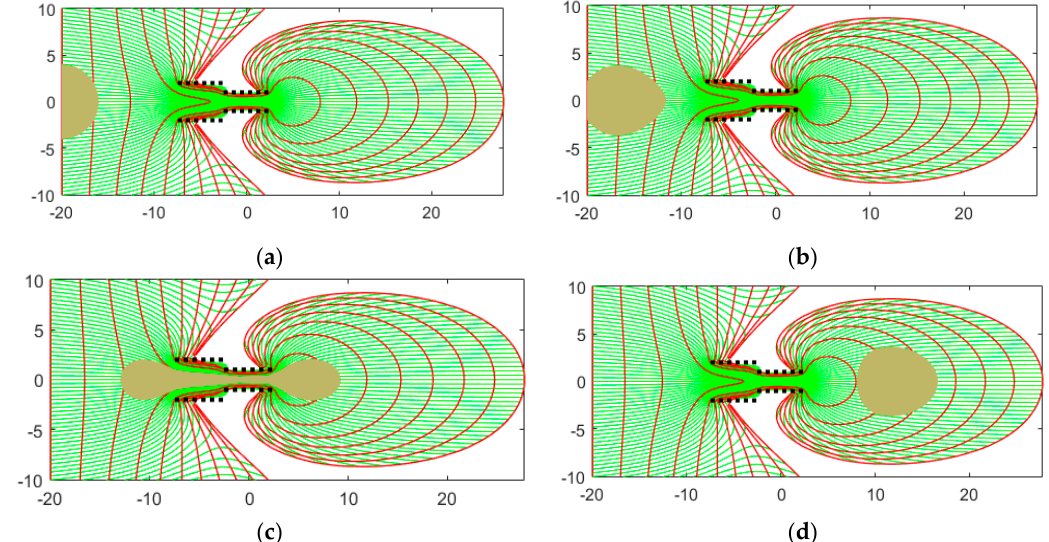
Figure 5. Movement of a passive ganglion (brown body) through elementary micro-pore domain in central part of the flow model. Dimensions of the pores, strength, and duration of simulation are the same as in Figure 3. Flow is steady and shows ( a ) initial position of the circular ganglion, with a radius of 4 × 10 − 6 m and ( b – d ) position and shapes of the ganglion after 60, 180, and 300 s, respectively. Length units are scaled in µ m (both x-axis and